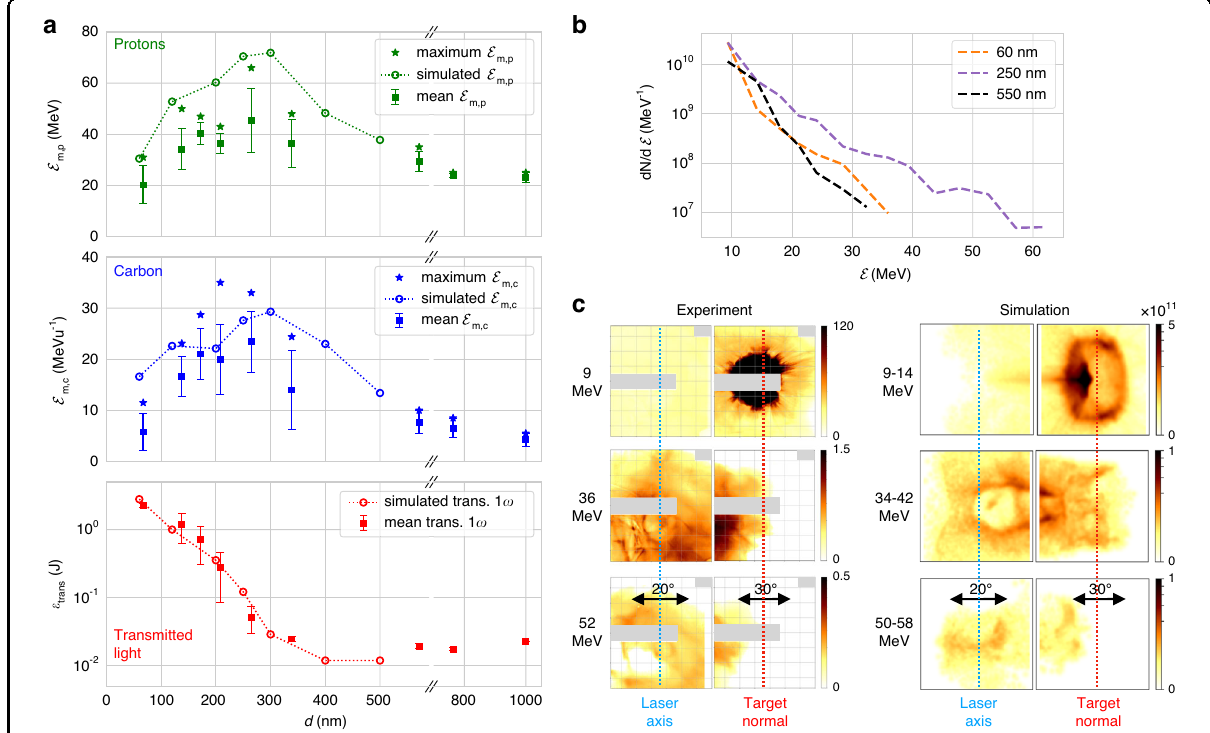
Fig. 2 Experimental observation of accelerated ions. a Maximum ion energies per nucleon E m recorded on the TPS detectors for different target thicknesses, which for d < 700 nm was on the 0° TPS and for d > 700 nm on the 45° TPS, for protons (top) and carbon (middle), together with the corresponding transmitted 1 ω laser energy Ɛ trans (bottom). Error bars represent the standard deviation and stars show maximum E m of shots in each thickness bin. Over 50 shots are included over the entire thickness range. Circles show the corresponding E m and Ɛ trans from 3D PIC simulations. b Proton spectra from RCF, combining the signal on both RCF stacks, for three example target thicknesses. c Proton beam spatial pro fi le at different energies for d = 250 nm. The experimental data (left, same shot as purple line in b ) gives dose (Gy) from RCF at different Bragg peak energies. The grey shaded area indicates regions not measured by the RCF. Equivalent synthesised pro fi les from 3D PIC (right) give the number of particles per steradian over the indicated energy range. The ring feature from 9 to 14 MeV is due to the small simulation box size, which arti fi cially limits the transverse extent of the sheath at the rear